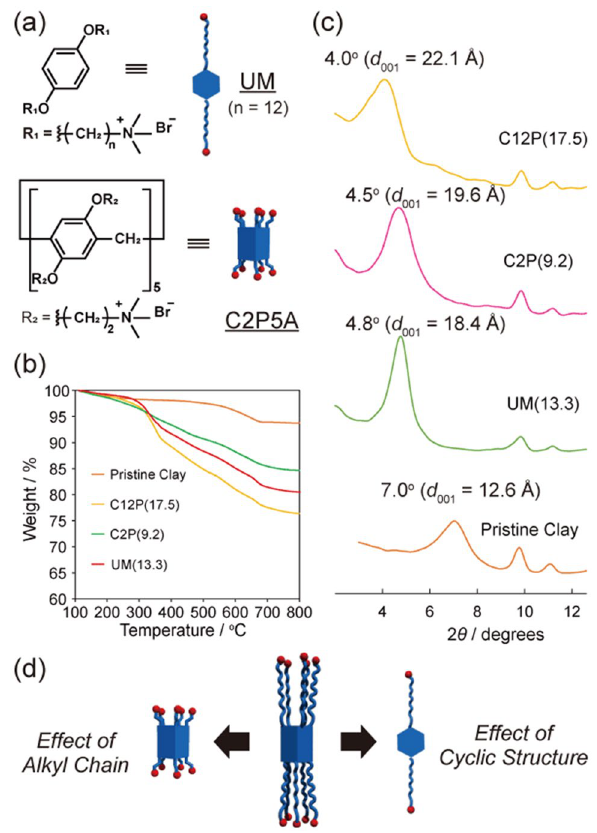
Figure 3. Effect of chain length and cyclic structure on clay modification. ( a ) Chemical structures of the model unit (UM) and C2P5A. ( b ) TGA traces of pristine clay, C12P(X), C2P(X), and UM(X) used to calculate their included amounts of C12P5A. ( c ) PXRD patterns for comparing intercalants. The peaks reveal different interlayer distances due to the intercalants. ( d ) Schematic of effective intercalation using